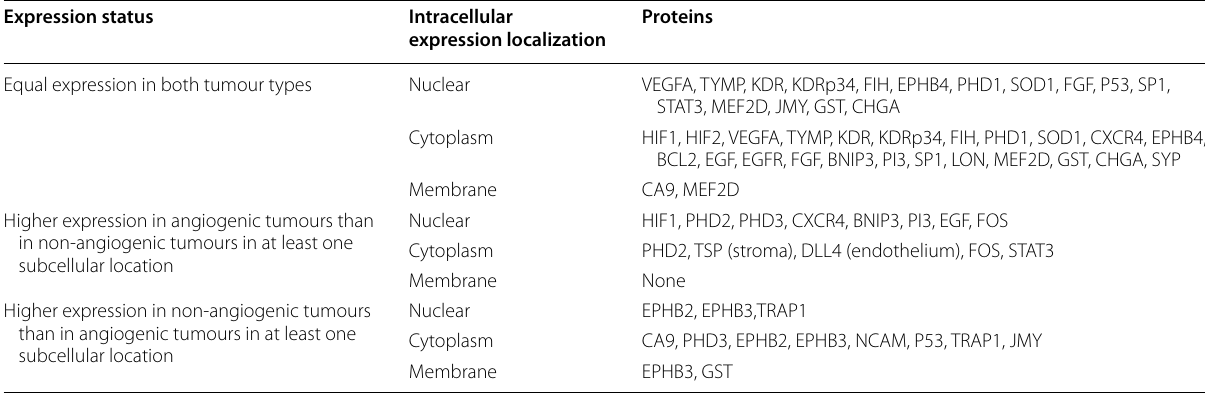
Table 6 Protein biomarker expression in angiogenic and non-angiogenic NSCLCs according to their intracellular localiza- tion